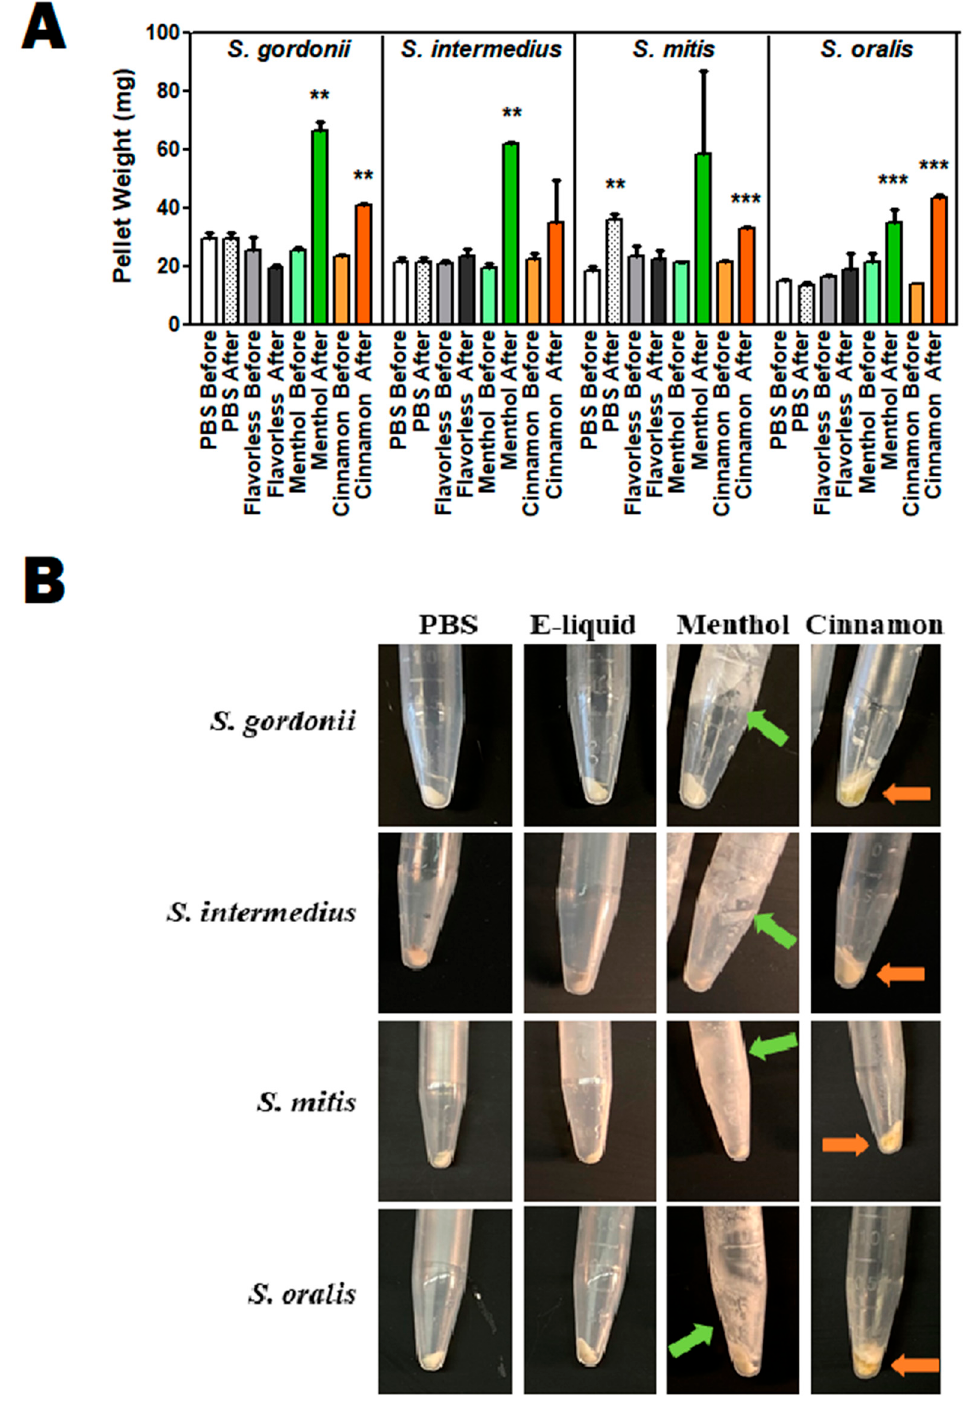
Figure 6. ( A ). Pellet Mass before and after E-liquid or stock flavor treatments. The weight of oral streptococci pellets was determined before and after treatment with 100 μ L of PBS, or 100 μ L of flavorless E-liquid, or cinnamon or menthol stock flavorings. Each bar represents mean ± SEM ( n = 3). ** p < 0.01, *** p < 0.001. ( B ). Pellet size of representative centrifuge tubes. Bacteria were exposed to 100 μ L of PBS, flavorless E-liquid, or cinnamon and menthol flavoring agents for 15 min. Bacteria were then washed and pelleted. Green arrows indicate precipitation of menthol crystals and orange arrows indicate the presence of a hydrophobic material associated with the cinnamon flavor.